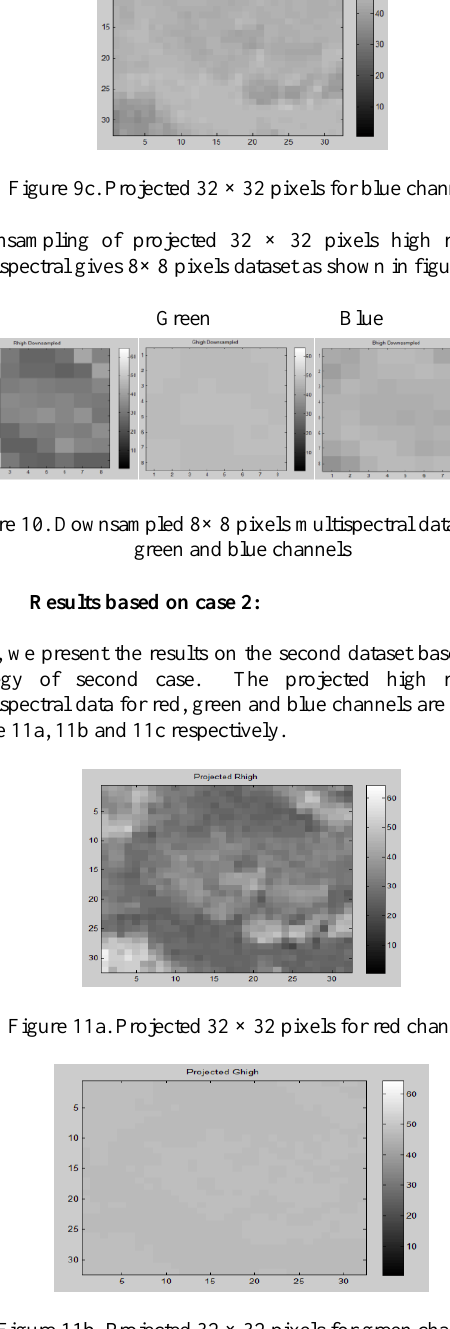
Figure 11b. Projected 32 × 32 pixels for green